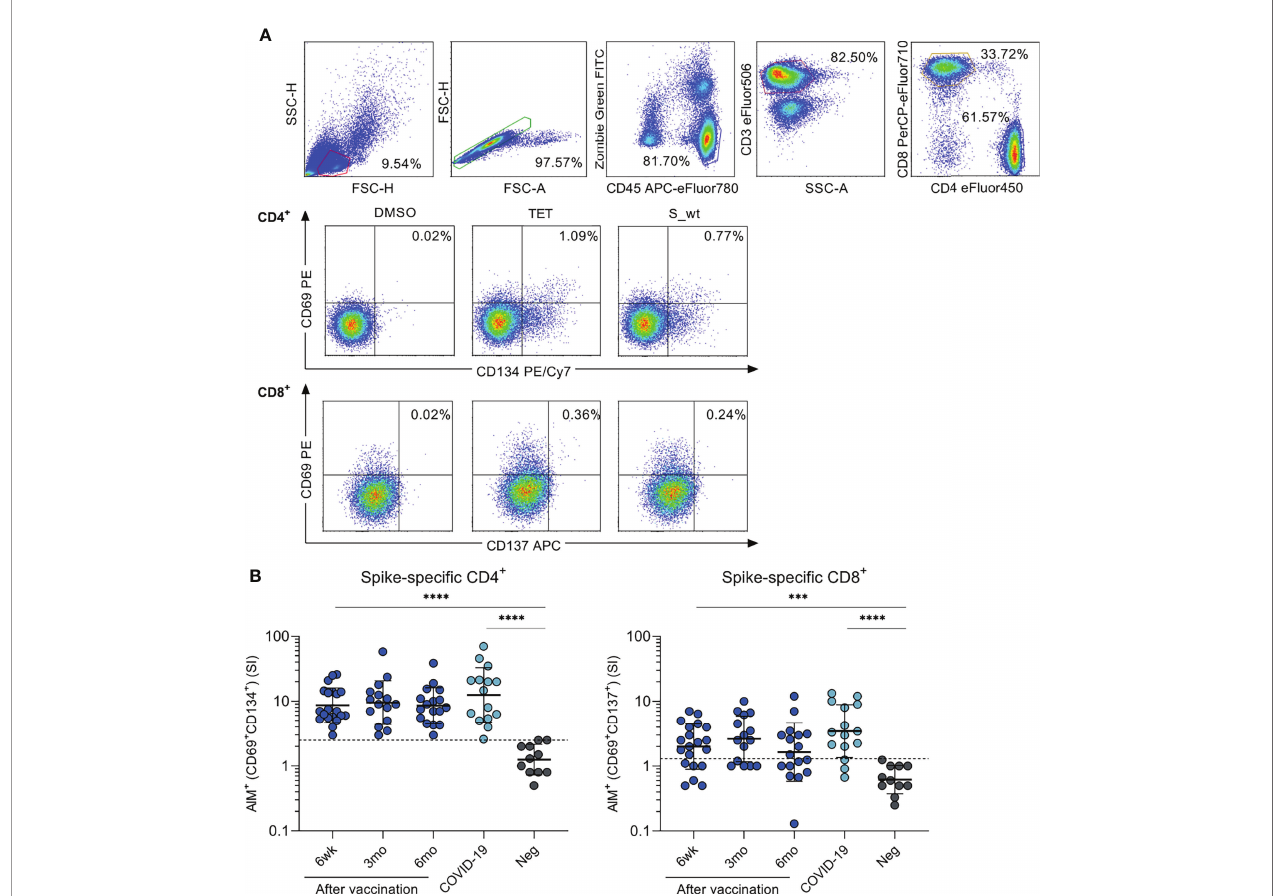
FIGURE 2 | SARS-CoV-2 spike-speci fi c CD4+ and CD8+ T cell responses after BNT162b2 vaccination. Peripheral blood mononuclear cells (PBMCs) collected from health care workers (HCWs) at different times after two doses of BNT162b2 vaccine were stimulated with wild type (wt) SARS-CoV-2 spike protein-speci fi c peptides for 48 h. (A) Representative graphs from one vaccinated individual illustrating the gating strategy used for all participants in fl ow cytometric analysis in T cell activation induced marker (AIM) assay. Antigen-speci fi c CD4 + responses were de fi ned with the expression of CD69 + and CD134 + , and CD8 + responses with the expression of CD69 + and CD137 + . Tetanus toxoid (TET) was used as a positive control in activation experiments. (B) PBMCs from BNT162b2 vaccinated HCWs (n=23), convalescent COVID-19 patients (n=15), and negative non-vaccinated controls (n=13) were stimulated with SARS-CoV-2 wild type spike protein peptide pool (0.5 µg/ml) for 48h. SARS-CoV-2 spike speci fi c responses are indicated as stimulation indices (SI) calculated by dividing the percentage of AIM + (CD69 + CD134 + ) CD4 + and AIM + (CD69 + CD137 + ) CD8 + T cells with the percentage of AIM + cells after DMSO stimulation. Results are from 20, 15, and 17 samples collected 6 weeks, 3 months, and 6 months after the fi rst vaccine dose, respectively, and 11 negative controls Comparisons between the groups were performed with the Mann-Whitney U-test and paired analysis was done with the Wilcoxon signed rank test. ***p < 0.001; ****p < 0.0001. The differences between 3wk, 3mo and 6mo sample groups were statistically not signi fi